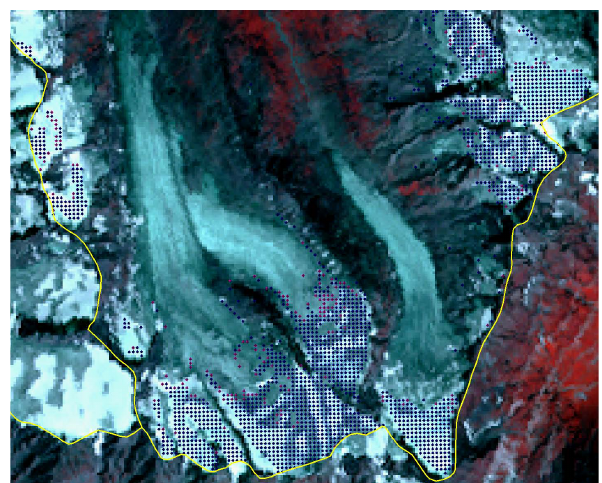
Fig. 2. Visual validation of the simulated snow cover on the glacier Gurglerferner on 13 September 1999 (dots=SWE > 0, blue=snow,